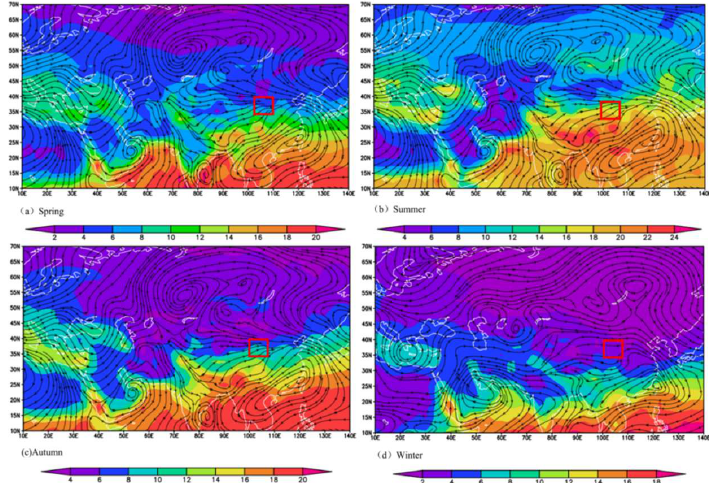
Figure 5. Vapor flux streamline and atmospheric precipitation from surface to 500 hPa based on NCEP/NCAR data: ( a ) Spring vapor flux streamline and atmospheric precipitation; ( b ) Summer vapor flux streamline and atmospheric precipitation; ( c ) Autumn vapor flux streamline and atmospheric precipitation; ( d ) Winter vapor flux streamline and atmospheric precipitation. Red dashed frames for each subfigure mark the study region.